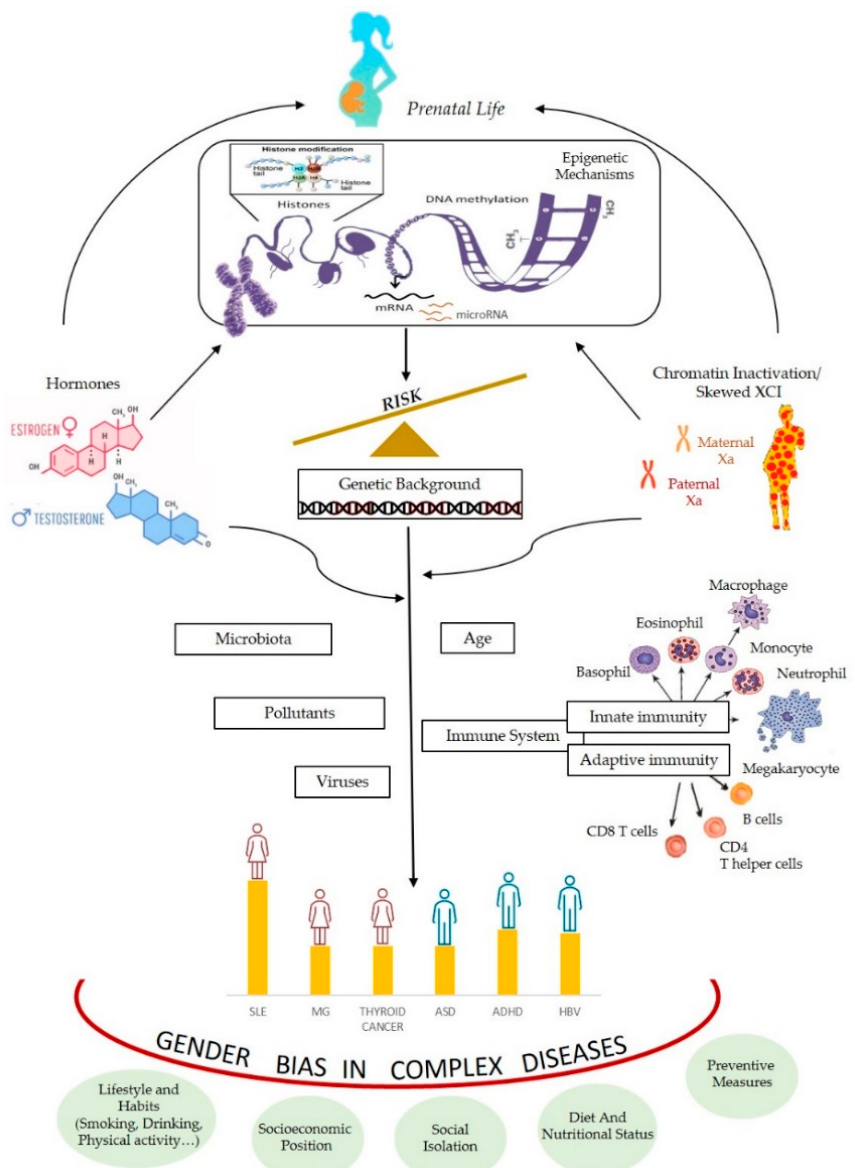
Figure 3. An integrated model of the multiple factors interfering with gender bias in complex diseases throughout epigenetic mechanisms (Xa; active X chromosome).